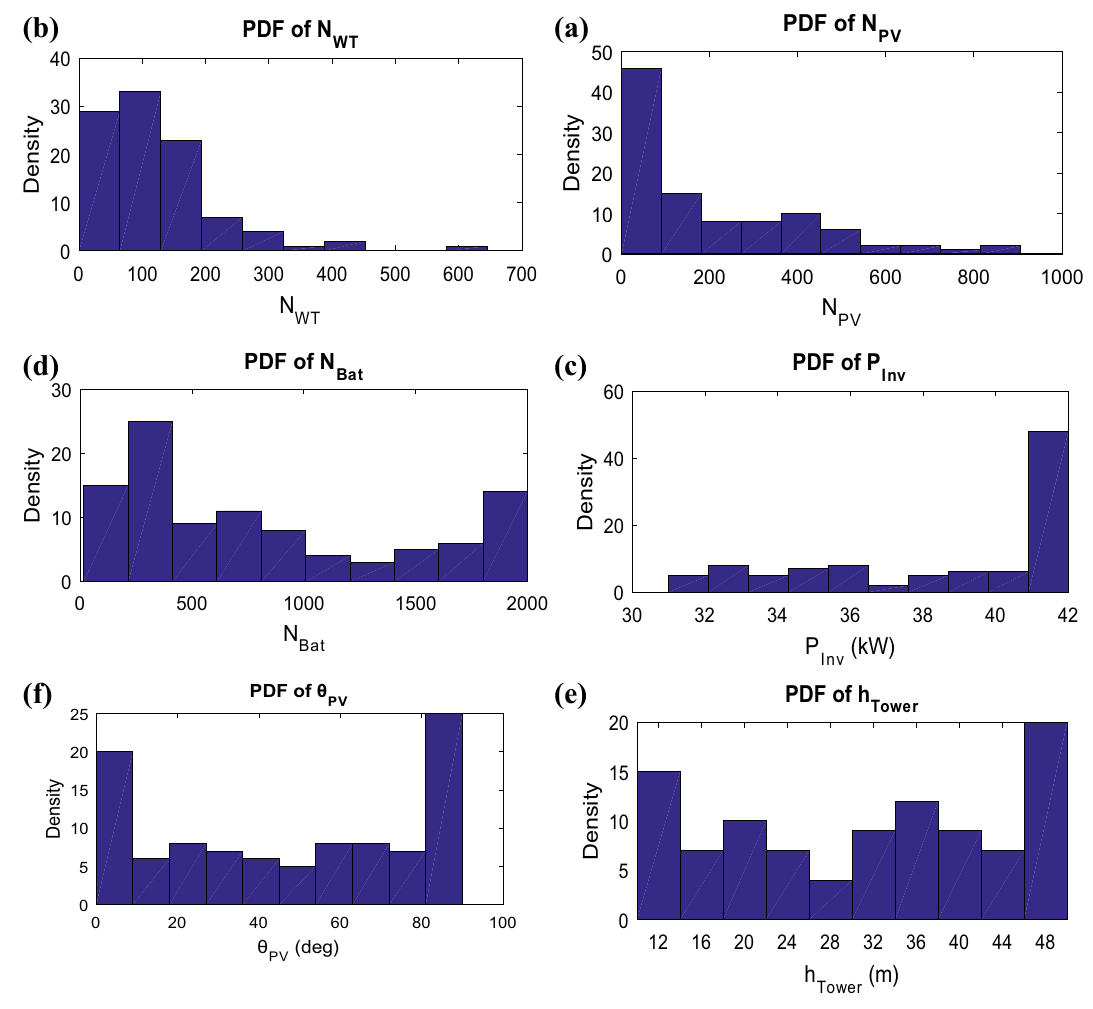
Fig. 9 PDF of decision variables a Number of PVs b Number of WTs c Number of batteries d Tranfered power to load by inverter e Wind tower height and f PV angle Table 4 Designing results of hybrid PV/WT/Batt system for DPHIPmax = 5% with C loss − load Parameters N WG N PV N Bat P Inv ( kW ) 𝜃 PV ( deg ) h Tower ( m ) TCHS ( M $) Without uncertainty – With